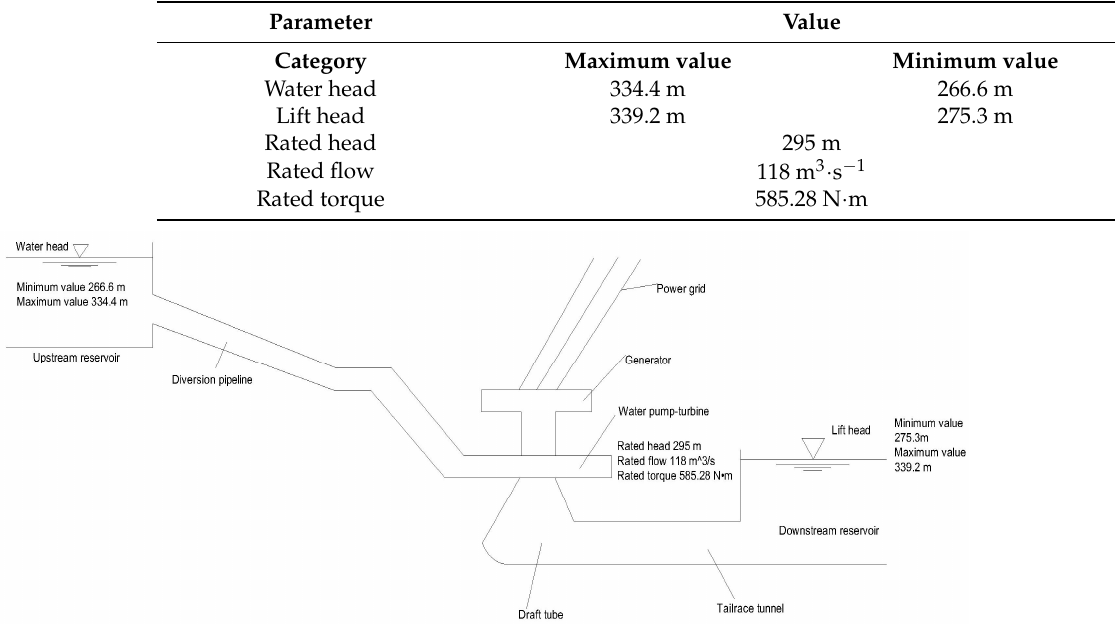
Figure 1. Schematic diagram of pumped storage power station structure.